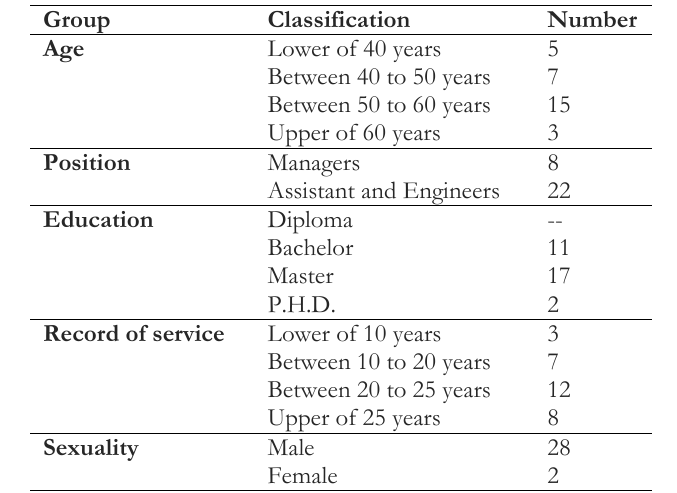
Table 5. Information of